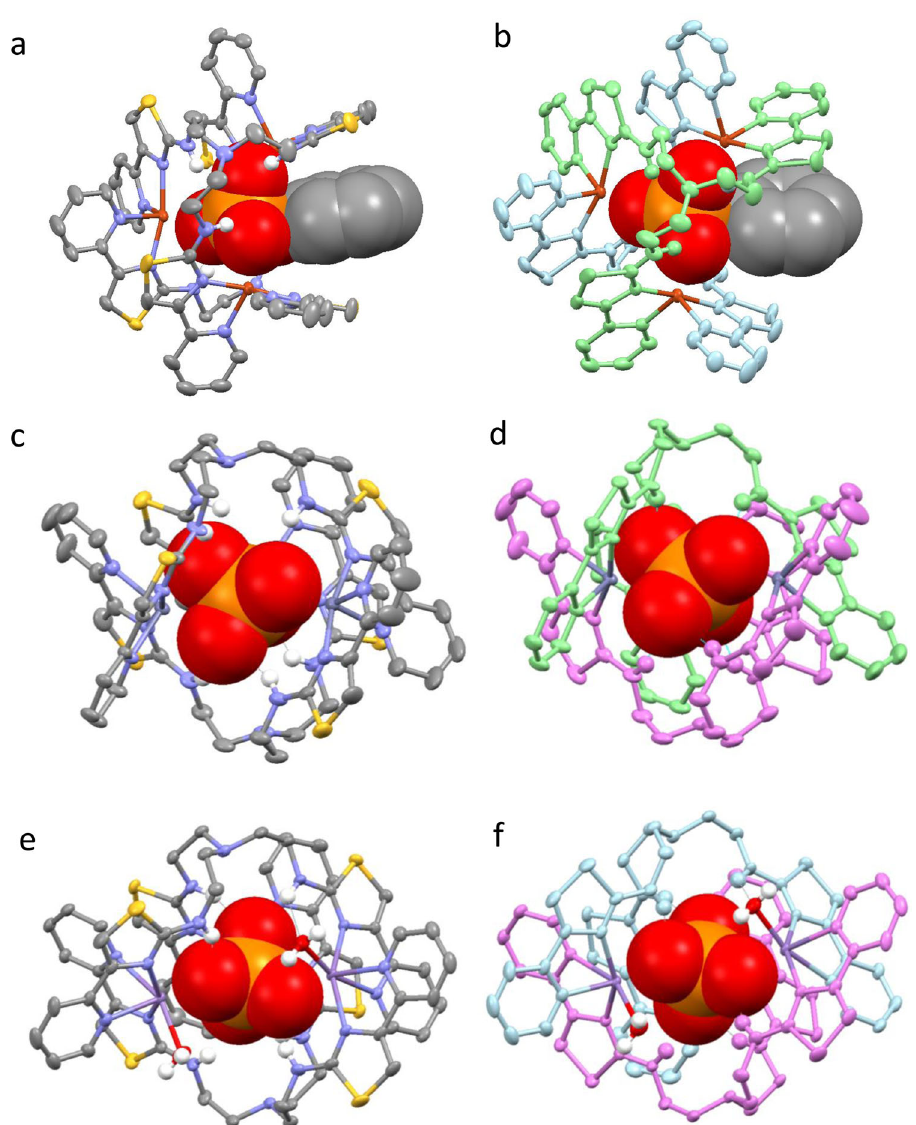
Fig. 3 X-ray structural analysis of the reaction of [L 2 Cu 3 ] 6 + , [L 2 Zn 3 ] 6 + and [L 2 Mn 3 ] 6 + with PhOPO 3 2 − . a [ L 2 Cu 3 (PhOPO 3 )] 4 + . b [ L 2 Cu 3 (PhOPO 3 )] 4 + . c [ L 2 Zn 3 (PO 4 )] 3 + . d [ L 2 Zn 3 (PO 4 )] 3 + . e [ L 2 Mn 3 (H 2 O) 2 (PO 4 )] 3 + . f [ L 2 Mn 3 (H 2 O) 2 (PO 4 )] 3 + . Colour code: dark orange, Cu(II); dark blue, Zn(II); purple, Mn; red, O; blue, N; yellow, S; grey, C; orange, P (apart from 2b, 2d and 2f where the ligand strands have been coloured